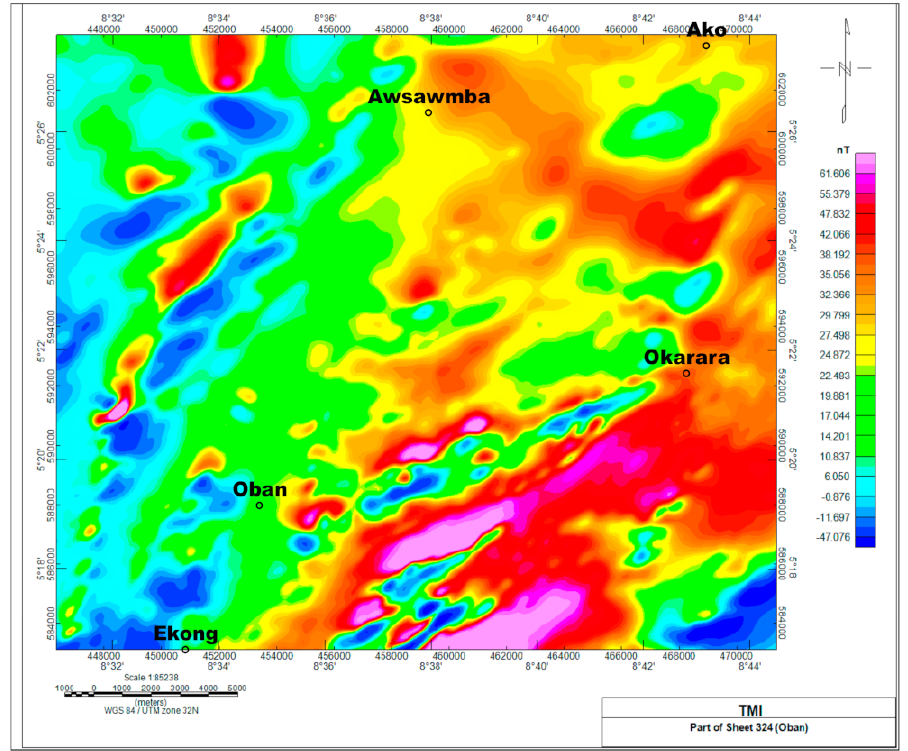
Figure 4. Total magnetic intensity map of the area under